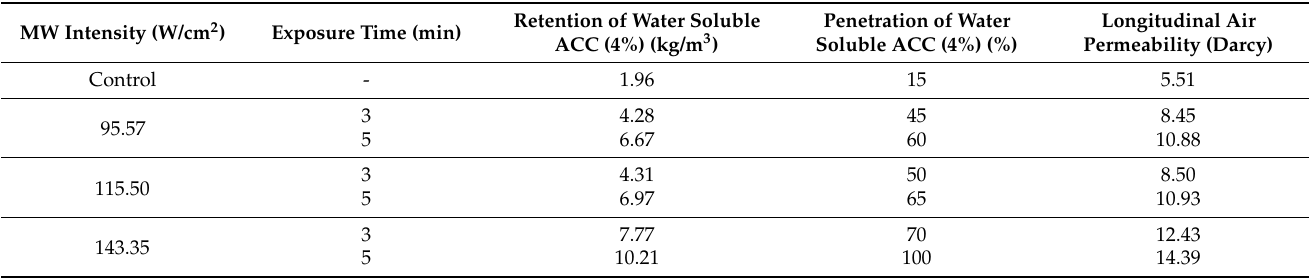
Table 11. Water solution retention and penetration found by [18].